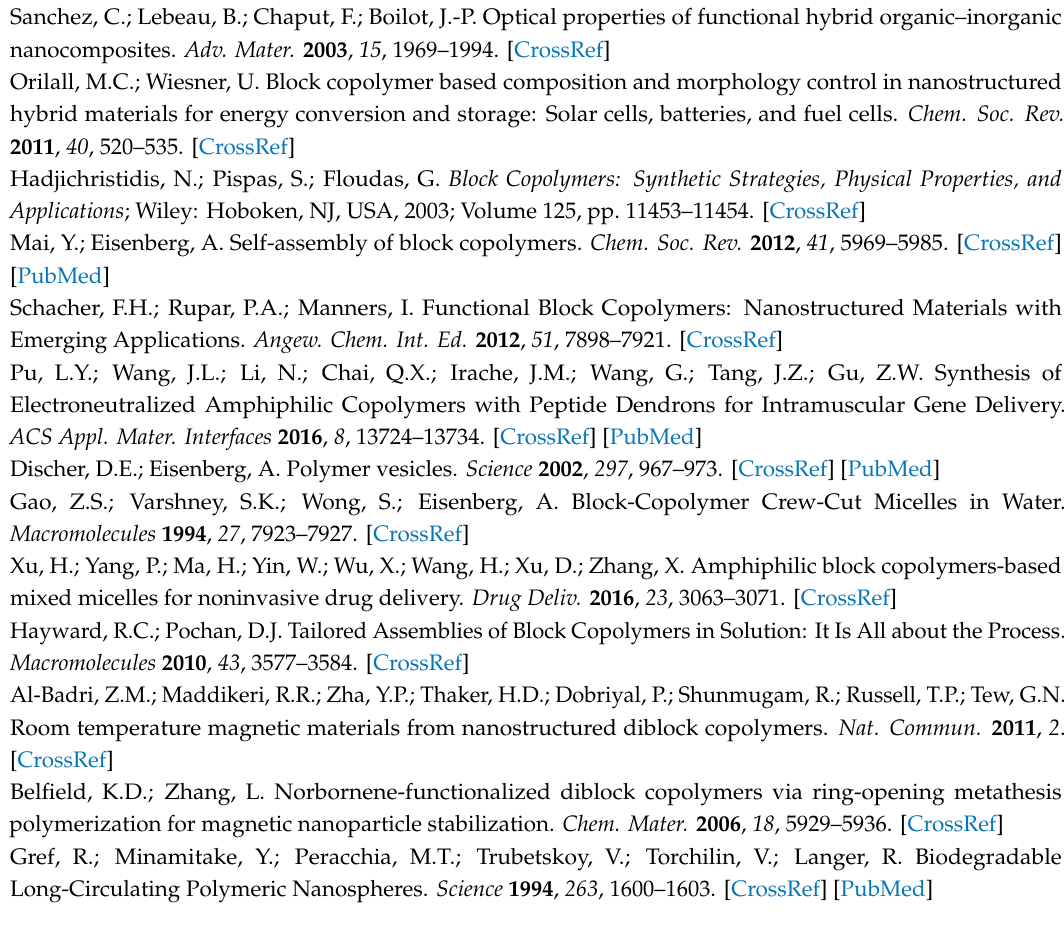
Figure S20. 31P{1H} NMR spectrum of phosphonate ester- and carbaborane-based block copolymer with a theoretical ratio m:n (4:1). Figure S21. 11B{1H} NMR spectrum of phosphonate ester- and carbaborane-based block copolymer with a theoretical ratio m:n (4:1). Figure S22. 1H NMR spectrum of phosphonate ester- and carbaborane-based block copolymer with a theoretical ratio m:n (1:1). Figure S23. 13C{1H} NMR spectrum of phosphonate ester- and carbaborane-based block copolymer with a theoretical ratio m:n (1:1). Figure S24. 31P{1H} NMR spectrum of phosphonate ester- and carbaborane-based block copolymer with a theoretical ratio m:n (1:1). Figure S25. 11B{1H} NMR spectrum of phosphonate ester- and carbaborane-based block copolymer with a theoretical ratio m:n (1:1). Figure S26. 1H NMR spectrum of phosphonic acid- and carbaborane-based block copolymer with a theoretical ratio m:n (4:1). Figure S27. 31P{1H} NMR spectrum